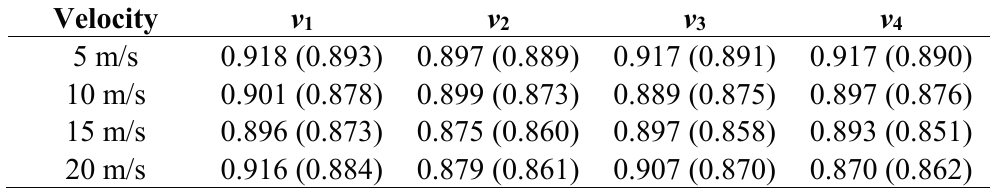
Table 3. Success rate of localization with different velocities in scenario 1 (2).